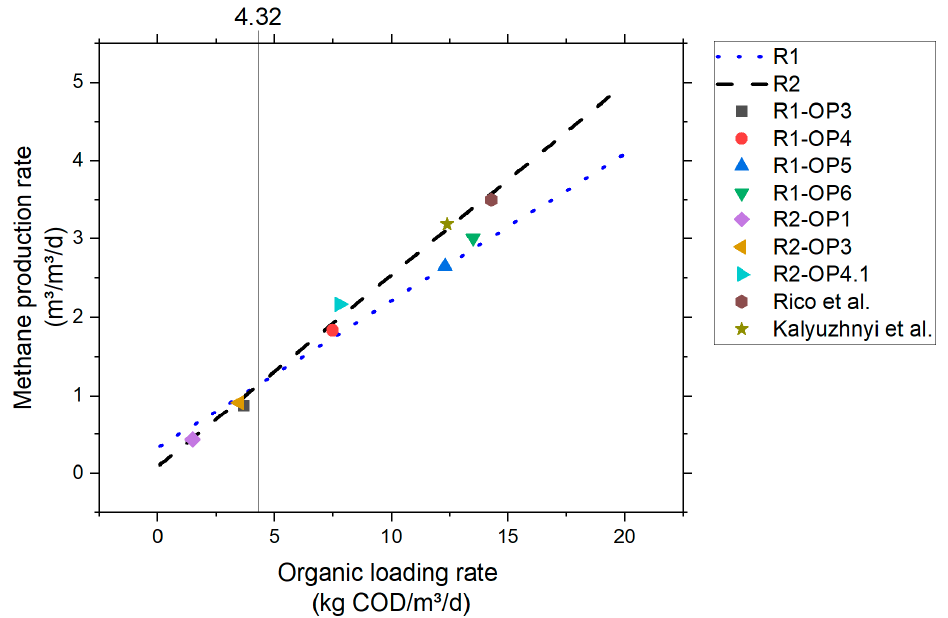
Figure 6. Linear regression models, average values from the selected OPs and results of Rico et al. [20] and Kalyuzhnyi et al. [50] in relation to the organic loading